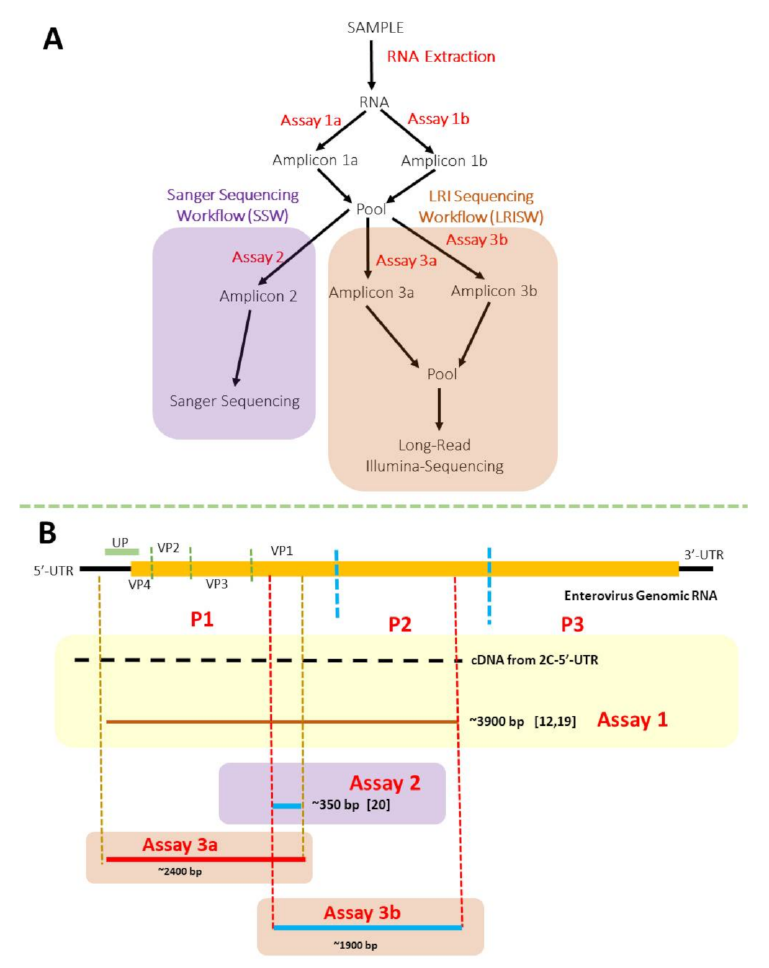
Figure 1. ( A ) Summary of the workflow used in this study. ( B ) The region of enterovirus genomes amplified in each of the assays. Abbreviation: LRI = long-read